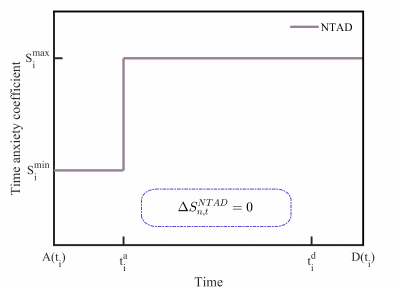
Figure 2. The time anxiety impact of